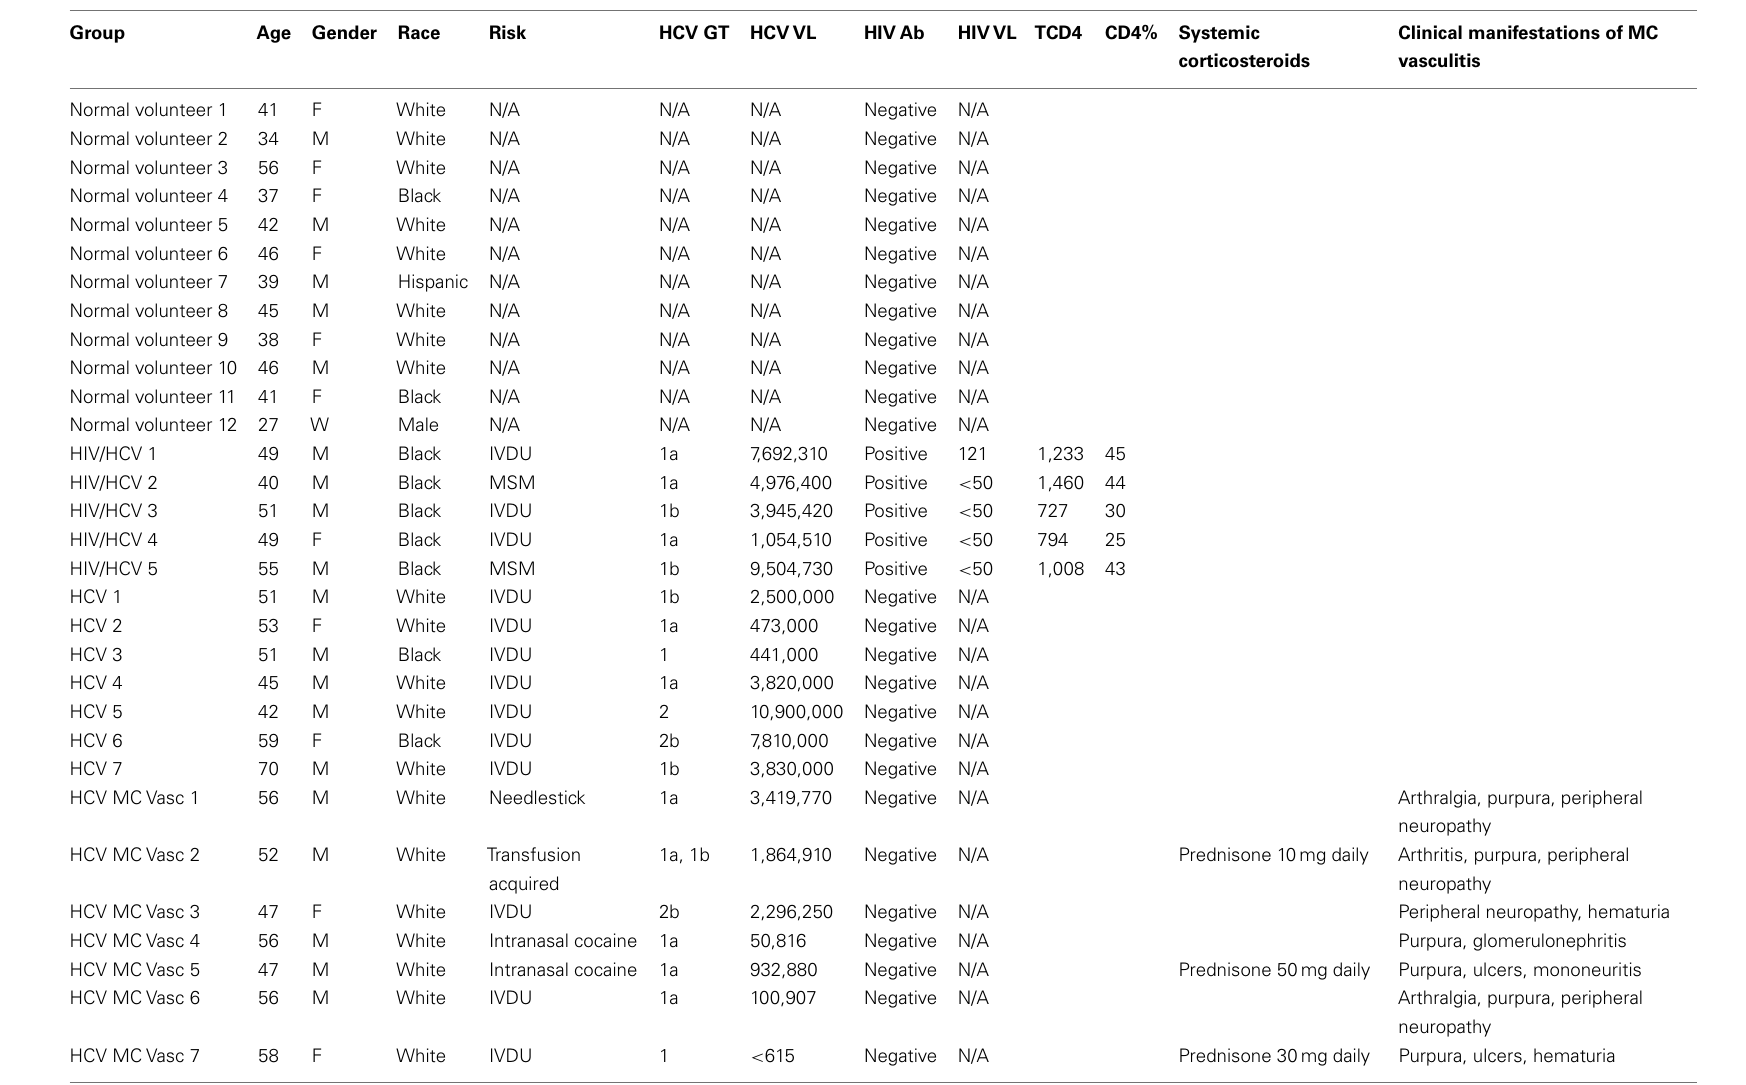
Table 1 | Demographics and clinical characteristics of study participants